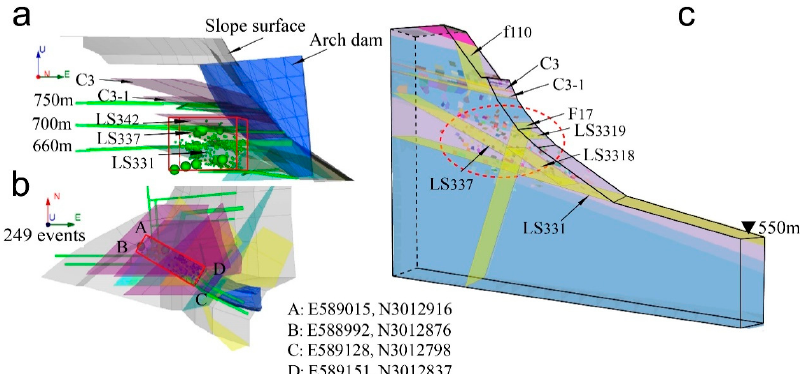
Figure 10. Import of MS data to the numerical model during the selected period between 1 April 2016 and 31 December 2016. ( a ) Front view, ( b ) top view, and ( c ) numerical model considering the MS effect.